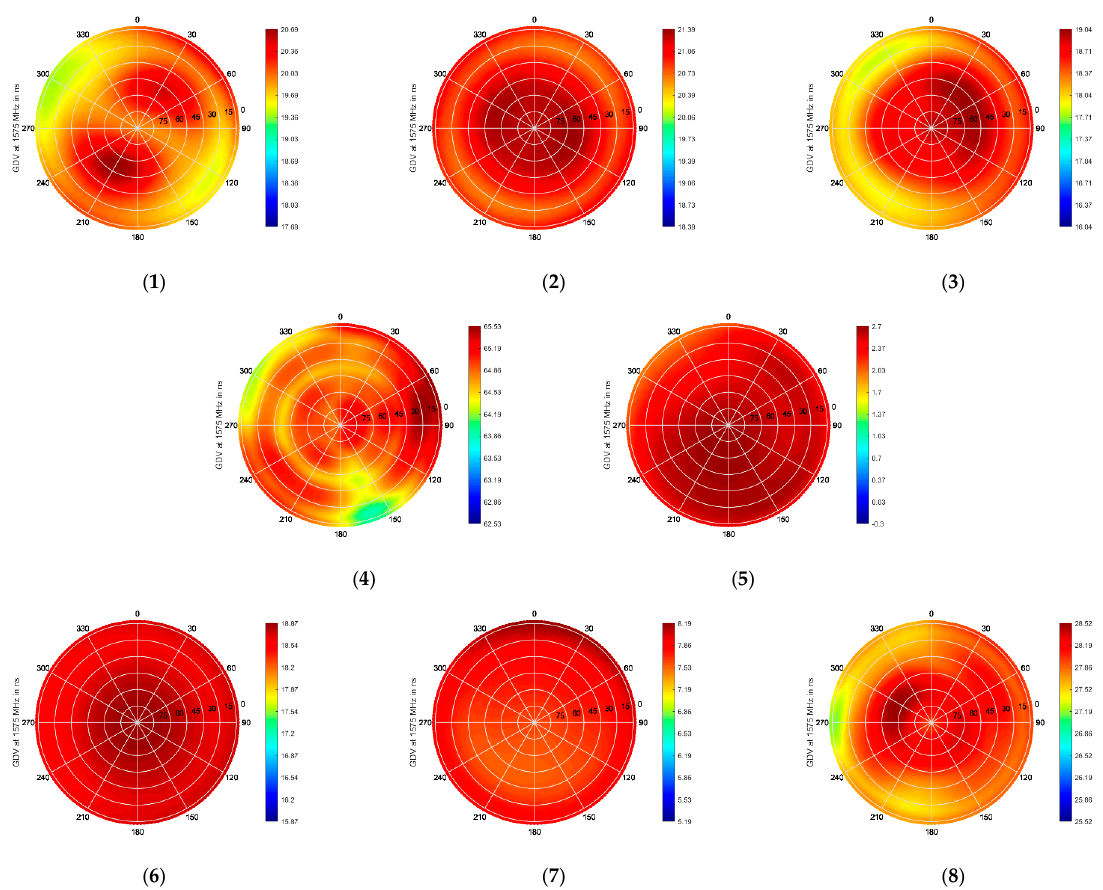
Figure A5. Group delay in ns at L1/E1 central frequency of the antennas measured at DLR; from left to right, from top to bottom: ( 1 ) Leica AR25 R4; ( 2 ) Novatel GNSS-750; ( 3 ) Javad RingAnt-DM; ( 4 ) Space Engineering GalExpAnt; ( 5 ) DLR internal design; ( 6 ) Novatel 703-GGG; ( 7 ) Navxperience Nav3G+C; ( 8 ) Tallysman VSE6028 VeroStar.